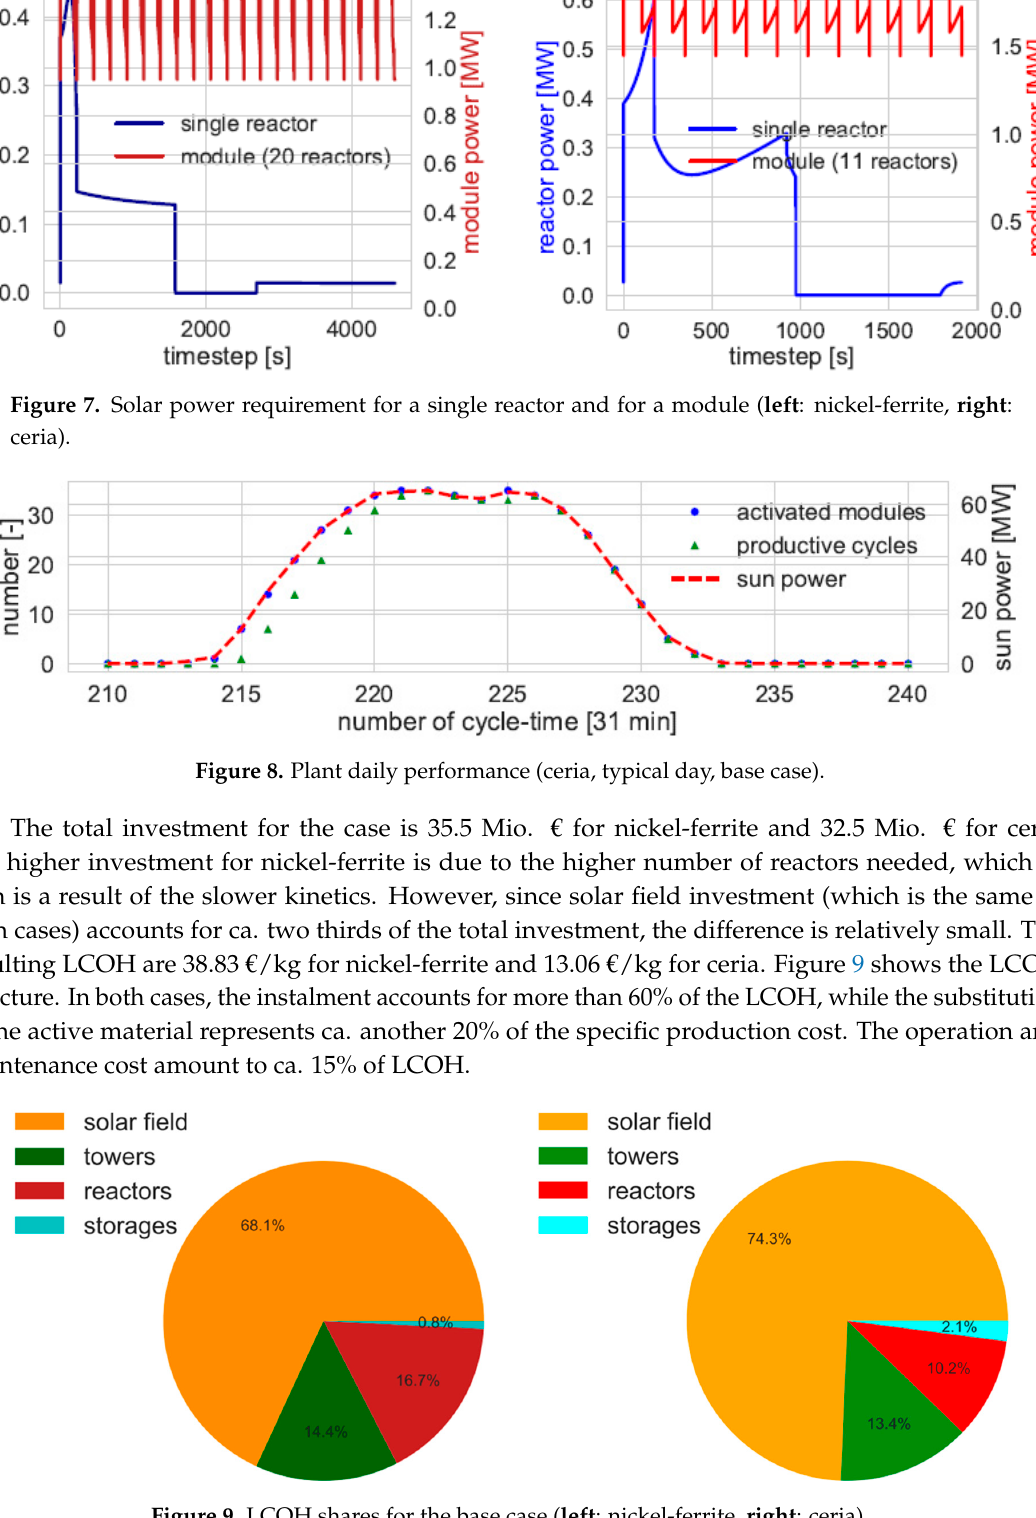
Figure 9. LCOH shares for the base case (left: nickel-ferrite, right: ceria).